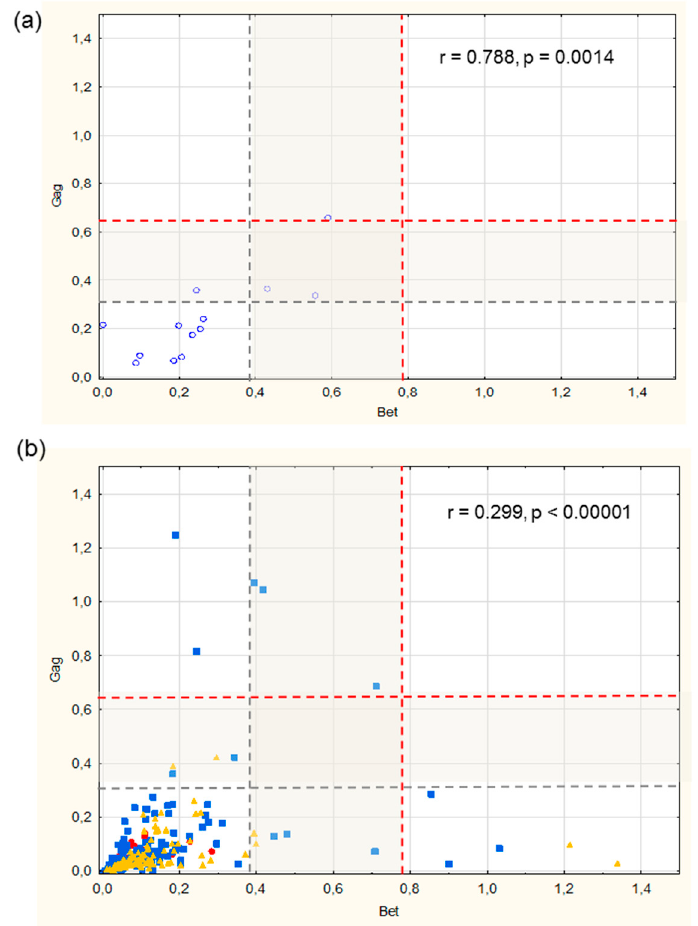
Figure 2. Distribution of Gag and Bet serological reactivity presented as scatter plots: ( a ) serum samples of bison origin, ( b ) serum samples of cervid origin. Each point represents a data pair of an individual serum of the following origins: blue dot—European bison, red dot—fallow deer, blue square—red deer, and yellow triangle—roe deer. Dashed lines, grey and red, indicate the cut-off values calculated in two ways grey—cut-off = 1× (mean + 3SD), red—cut-off = 2× (mean + 3SD). The grey boxes between the dashed lines indicate the grey zones of inconclusive ELISA results. The upper right sector shows double-positive, the lower-left double-negative, the lower-right sector displays sera positive for Bet only, and the upper left sector represents sera positive for Gag exclusively. The correlation coefficient (r) and p -value (p) are indicated in the graphs.